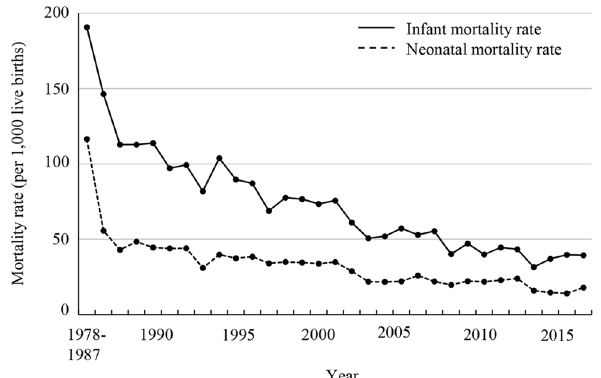
Figure 1. The trends of infant mortality rate (IMR) and neonatal mortality rate (NMR) from 1978 to 2017 in Lao PDR. The estimated IMR and NMR gradually decreased from 1978 to 2017. The difference between the IMR and NMR had been declining since 1978, however, this decreasing trend stopped after 2009.